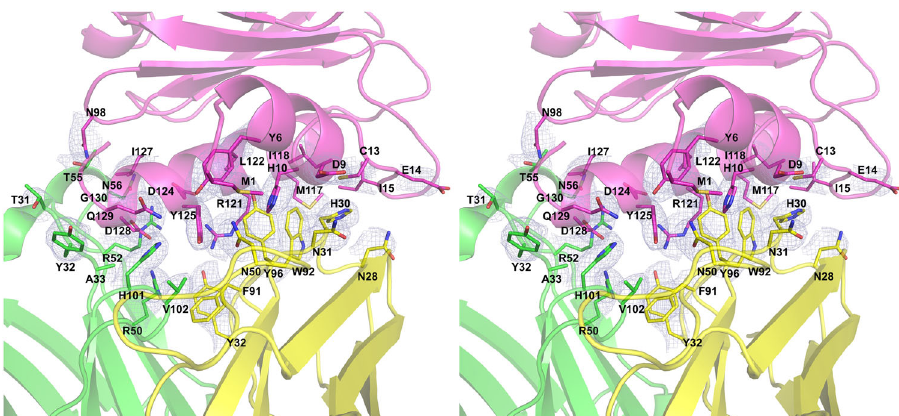
Fig. 5 Stereo-view of the paratope-epitope interface. Fab/IgE 2F5 light chain (yellow), heavy chain (green) and pro fi lin (pink), the 2Fo-Fc electron density map (1 σ ) is shown in light blue. The epitope-paratope interface area (926 Å 2 ).